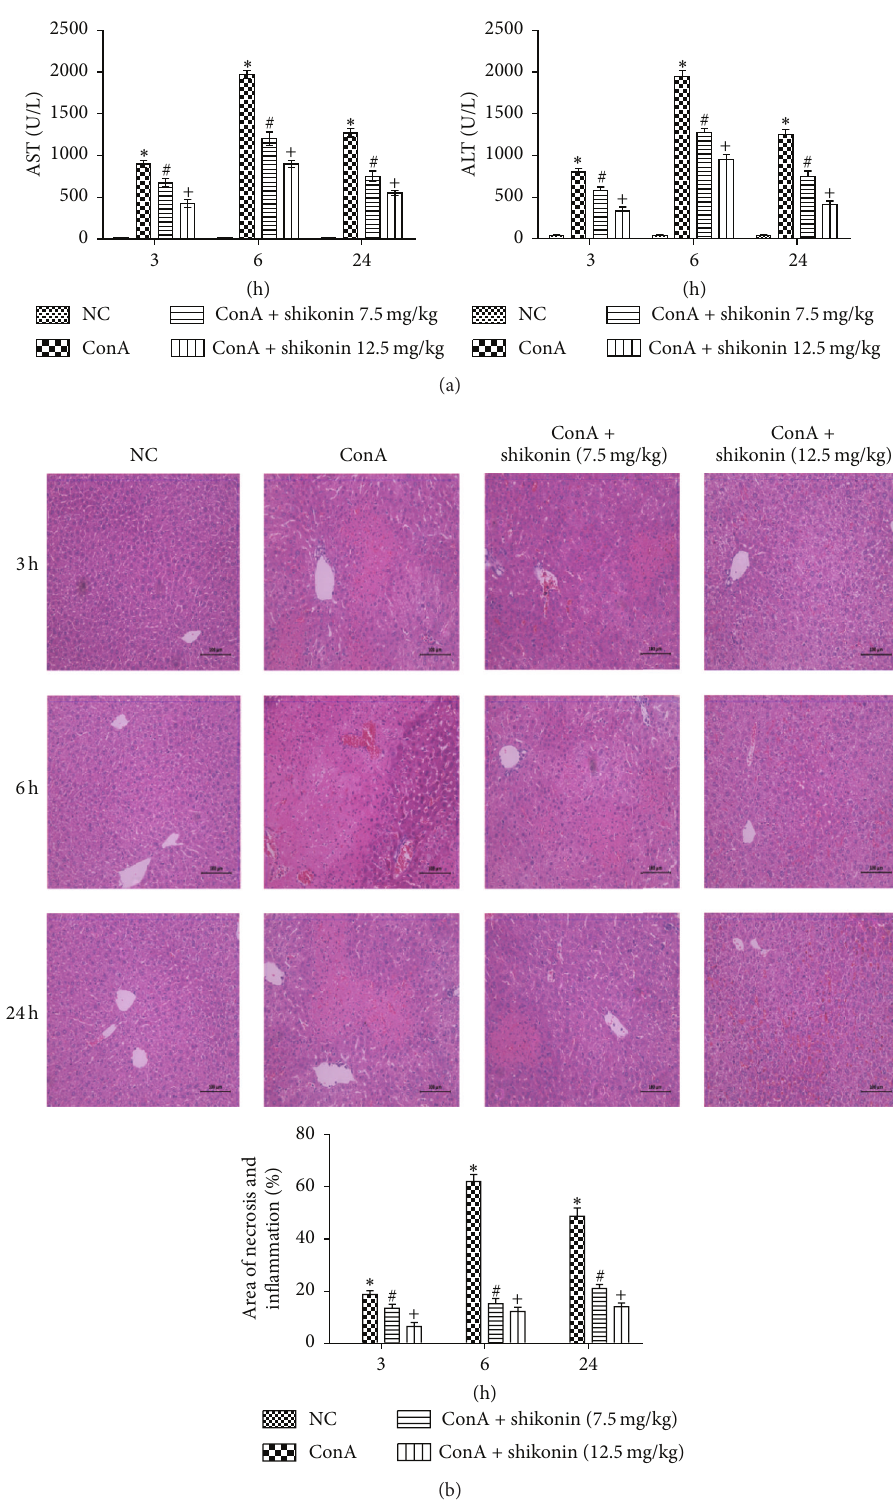
Figure 2: Effects of shikonin on liver function and pathology of mice with ConA-induced acute hepatitis. (a) The levels of serum ALT and AST changed depending on the shikonin dose, 7.5 mg/kg or 12.5 mg/kg. Data are given as means ± SD ( 𝑛 = 8 , ∗ 𝑃 < 0.05 for NC versus ConA, # 𝑃 < 0.05 for ConA + shikonin (7.5) versus ConA, and + 𝑃 < 0.05 for ConA + shikonin (12.5) versus ConA). (b) The necrotic and edematous area stained with hematoxylin and eosin and used for the liver sections was analyzed with Image-Pro Plus 6.0 (magnification, × 200). The results show statistically significant differences among the different groups ( 𝑛 = 8 , ∗ 𝑃 < 0.05 for NC versus ConA, # 𝑃 < 0.05 for ConA + shikonin (7.5) versus ConA, and + 𝑃 < 0.05 for ConA + shikonin (12.5) versus